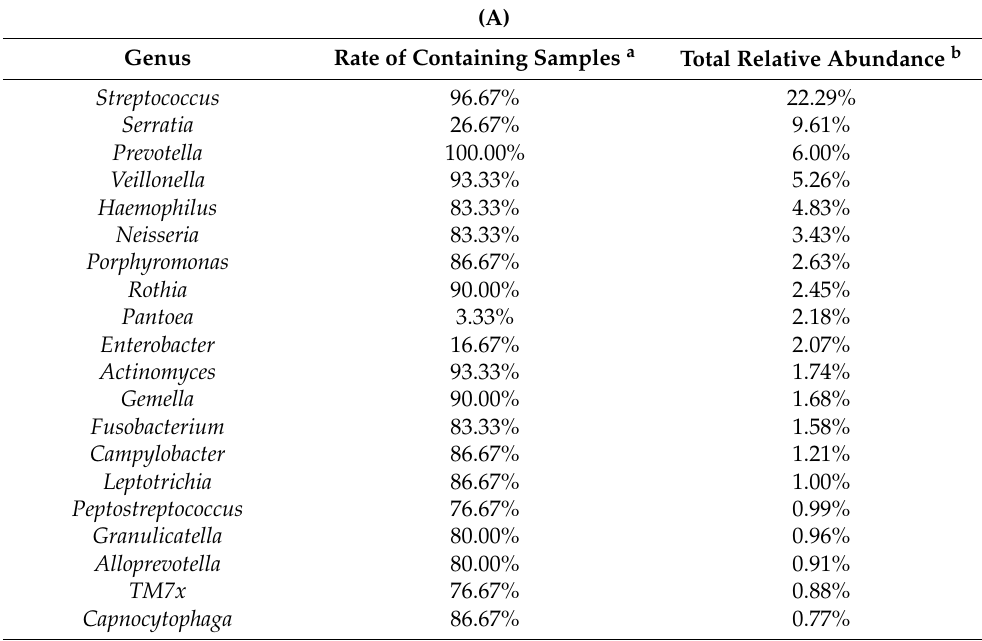
Table 2. ( A ) Top 20 abundant genera in the saliva sample. ( B ) Top 20 abundant genera in the tissue sample. ( C ) Top 20 abundant genera in the stool